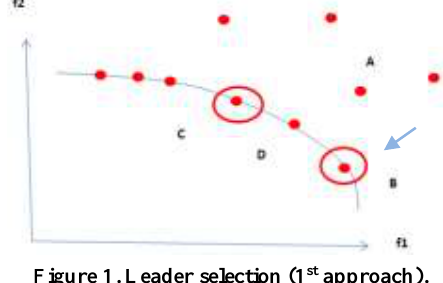
Figure 3. Leader